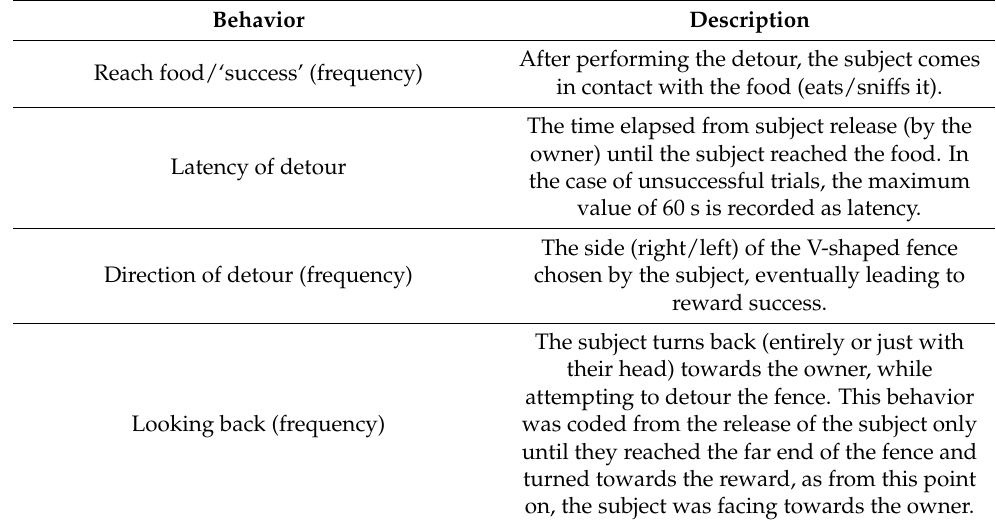
Table 1. List of coded behaviors and